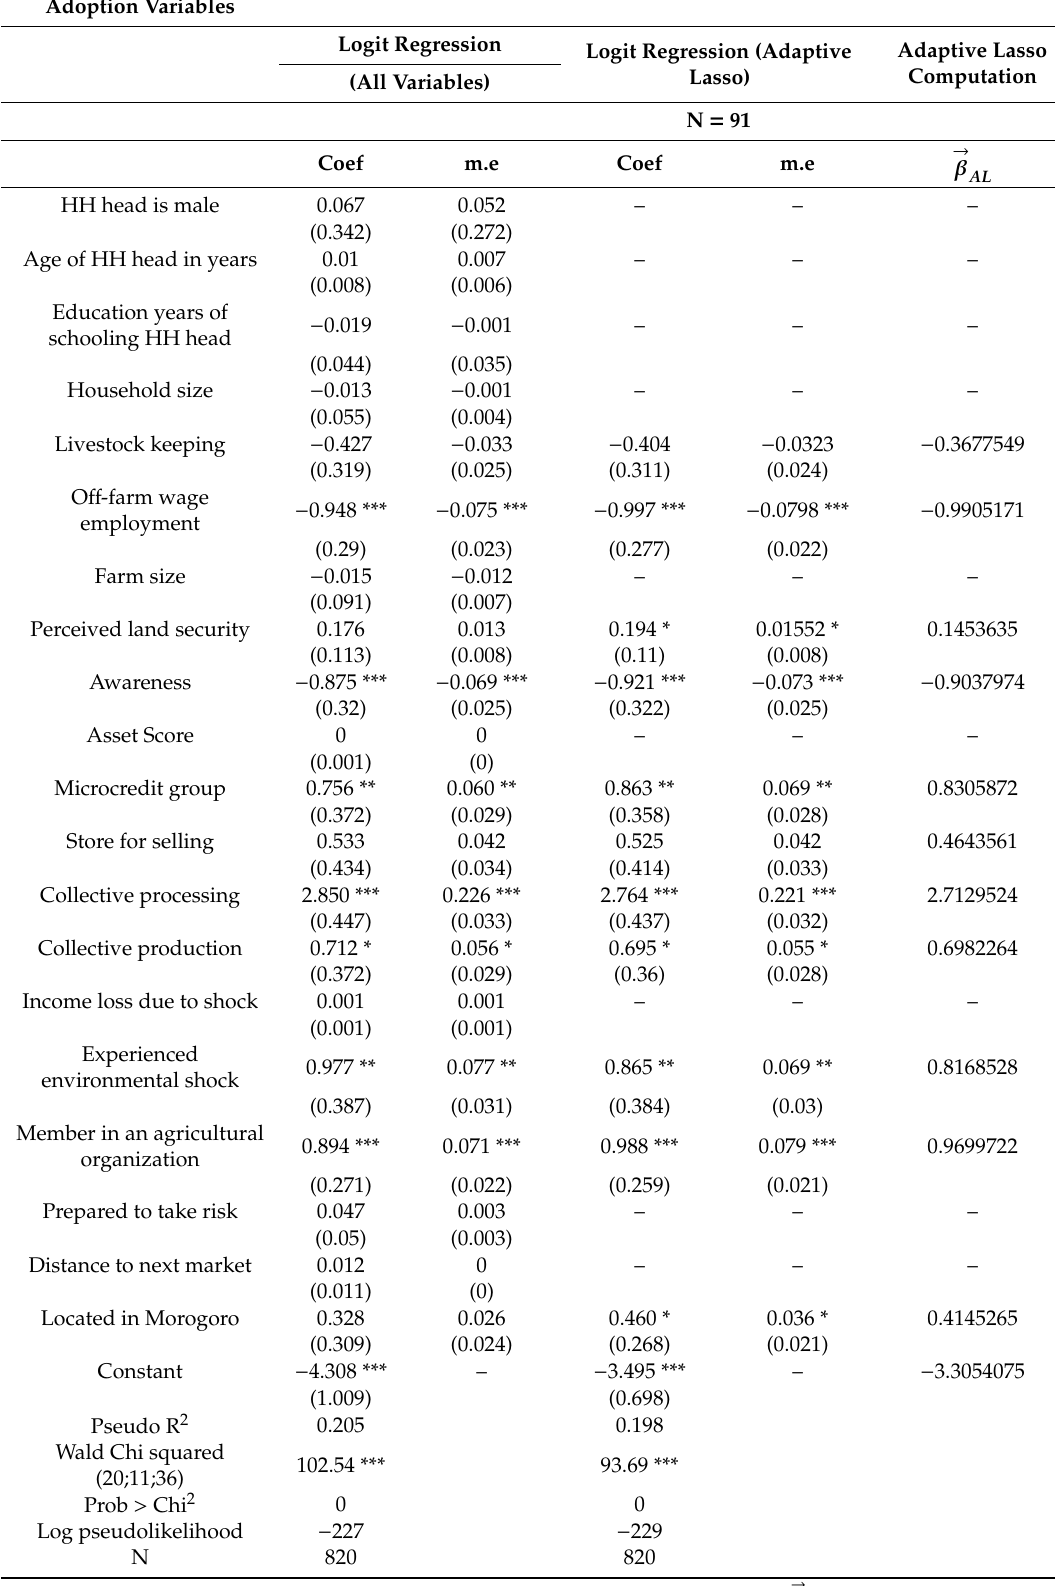
Table2. Factorsthatinfluencetheadoptiondecisionofupgradingstrategies(UPS)inTanzania—estimates from logistic regression and the adaptive